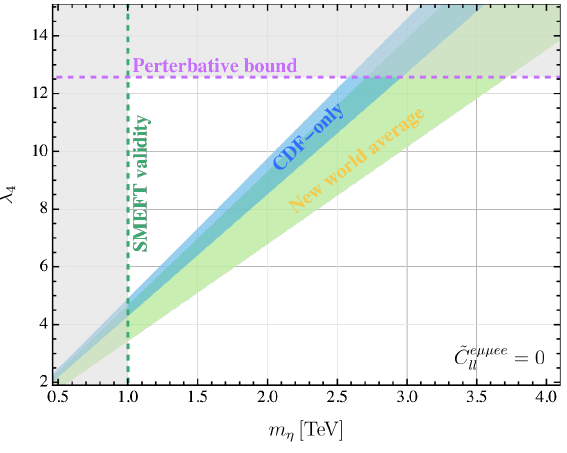
Figure 2 . The allowed region in the m η – λ 4 plane for explaining the W boson mass anomaly at the 1 σ